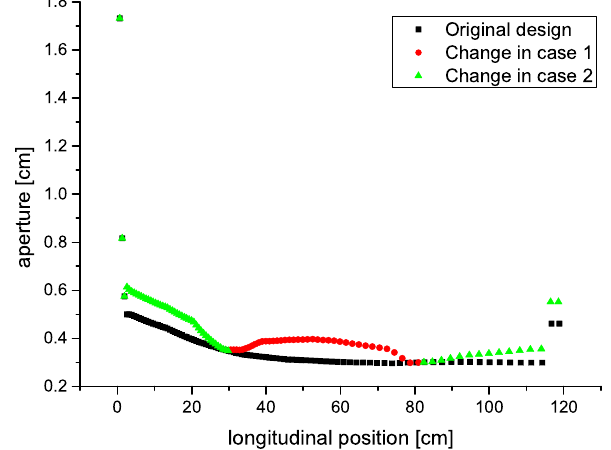
FIG. 14. Radial displacement of the electrodes with a 1 mm enlarged aperture in the middle section (case 1) or at both ends (case 2) of the electrodes.